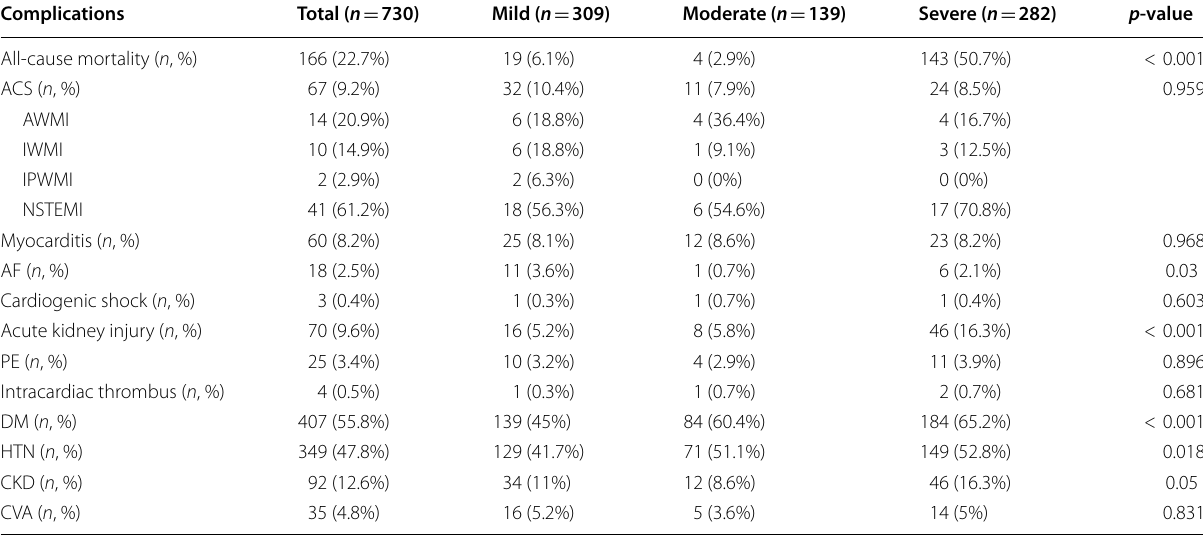
ACS acute coronary syndrome, AF atrial fibrillation, AWMI anterior wall myocardial infarction, IWMI inferior wall myocardial infarction, IPWMI infero-posterior wall myocardial infarction, NSTEMI non-ST segment elevation myocardial infarction, PE pulmonary